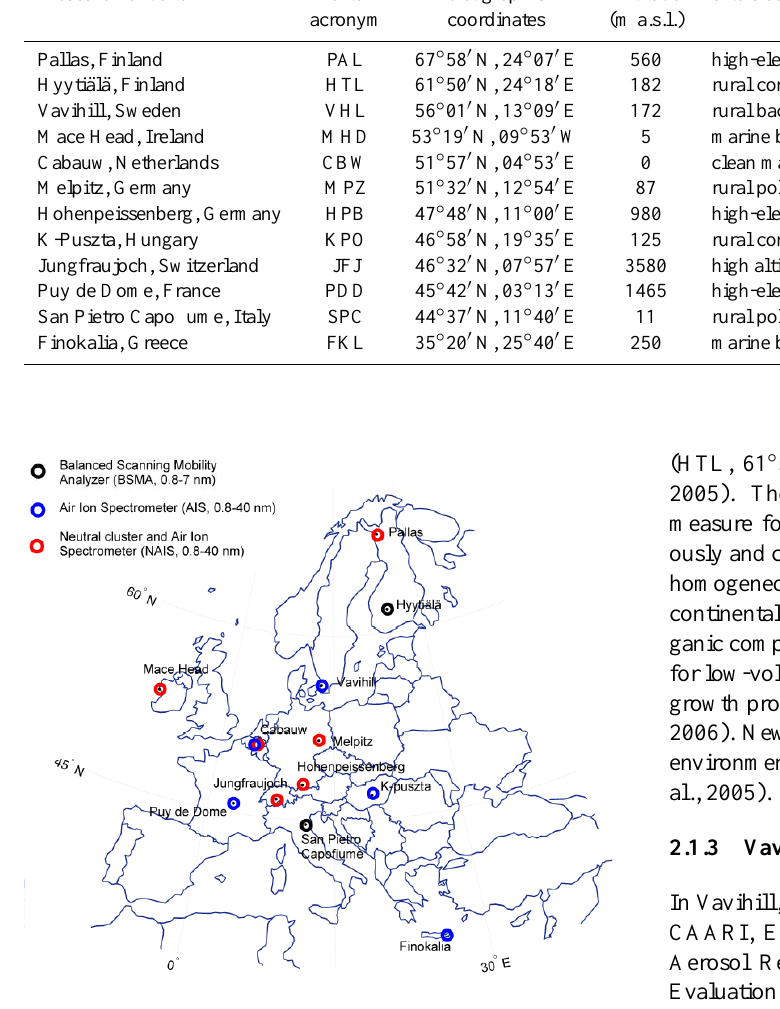
Fig. 1. Comprehensive field measurements were conducted at 12 field sites around Europe marked with a circle during March 2008– May 2009 within the EUCAARI project. The colour of the circle refers to the instrument type used at the site as indicated in the upper left corner